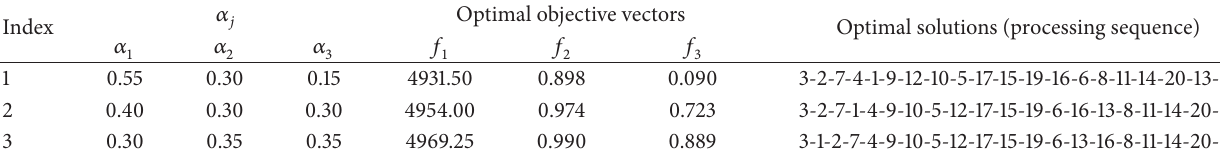
Table 7: Three examples of determining the processing sequence for the 20 × 7 fuzzy FSSP using MOPSO-M.